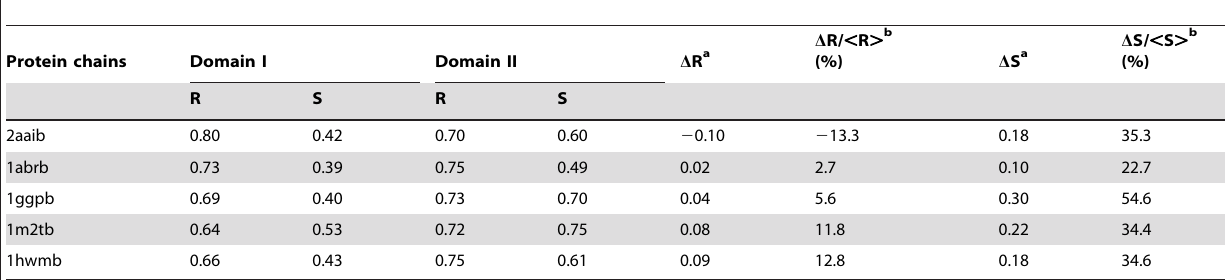
Table 2. Sequence symmetries for five representative protein chains.